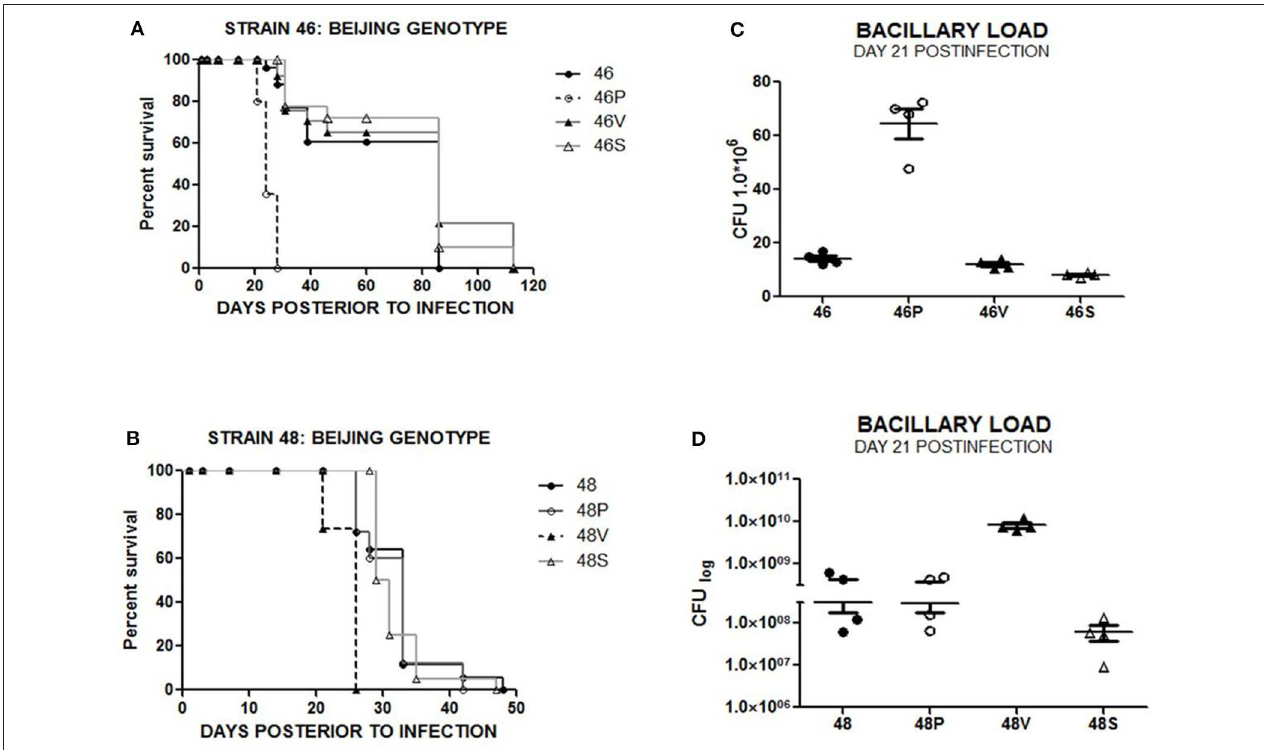
FIGURE 2 | (A) Survival rate for animals infected with strains 46, 46P, 46V, and 46S ( n = 50 subjects/strain). (B) Survival rate for animals infected with strains 48, 48P, 48V, and 48S ( n = 50 subjects/strain). (C) Bacillary load in lungs from animals infected with strains 46, 46P, 46V, and 46S at day 21 postinfection. (D) Bacillary load in lungs from animals infected with strains 48, 48P, 48V, and 48S at day 21 postinfection.